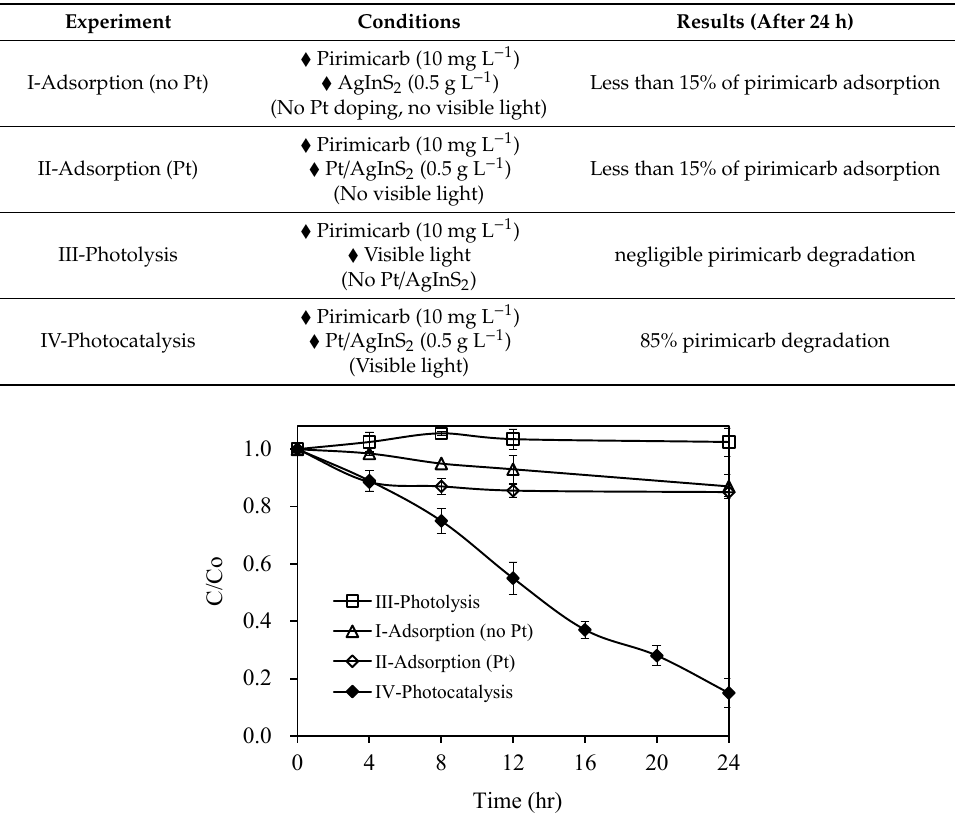
Figure 6. Pirimicarb degradation under control conditions (Pt / AgInS 2 only and visible light only) and photocatalytic conditions (experimental conditions: pirimicarb = 10 mg L − 1 , Pt / AgInS 2 = 0 g L − 1 in photolysis, 0.5 g L − 1 in photocatalysis, visible light 1420 lux in photolysis and photocatalysis conditions). Error bars represent the standard deviations of duplicate runs.